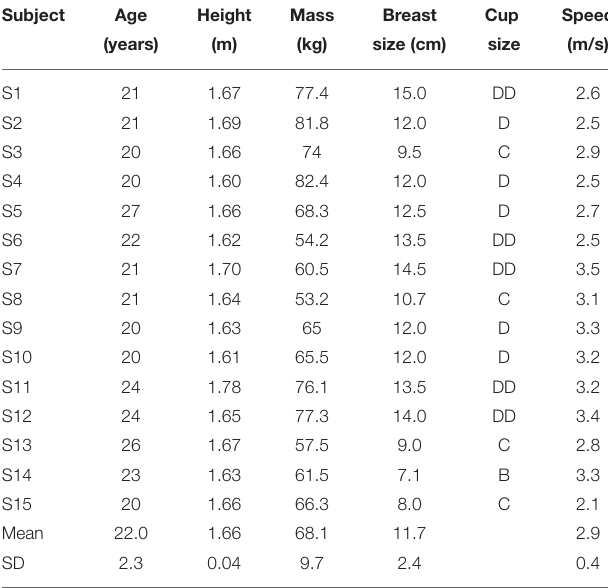
TABLE 1 | Individual participant anthropometric data including age, height, mass, breast size and cup